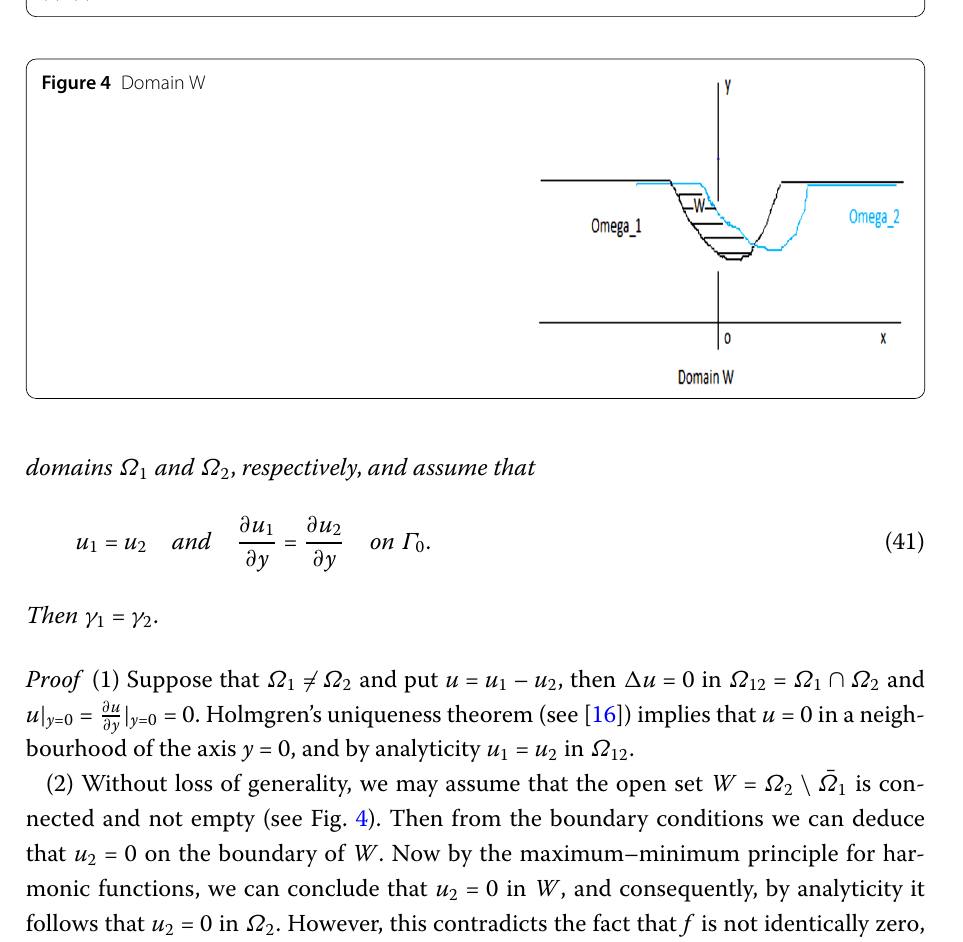
Figure 3 (left) Solution u 0 of the unperturbed problem; (right) Solution u = v 0 + u 0 of the direct problem (2)–(3)